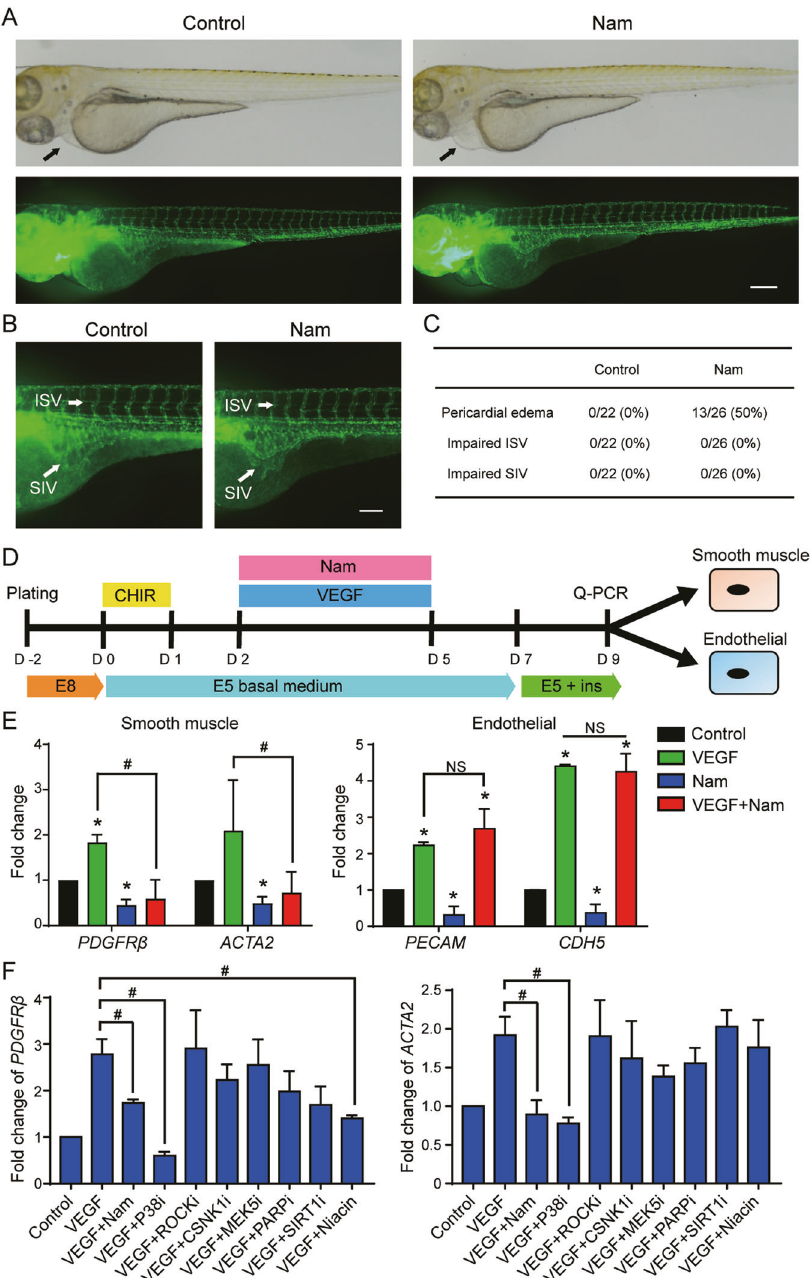
Fig. 7 The in fl uence of nicotinamide in zebra fi sh cardiovascular system development. A Effect of nicotinamide on the development of The Tg(Fli1:EGFP) transgenic zebra fi sh. Nicotinamide was applied between 18 and 24 h post fertilization. The images were taken after 3 days of treatment. Top, the bright fi eld images of zebra fi shes; Bottom, the fl uorescence images. Scale bar, 200 μ m. B The enlarged images showing the intersegmental vessels (ISV) and subintestinal veins (SIV) of zebra fi shes. Scale bar, 100 μ m. C Percentage of zebra fi sh with pericardial edema, impaired ISV, or impaired SIV ( n = 22 in control group, and n = 26 in nicotinamide group). D The schematic diagram showing the protocol of endothelial and smooth muscle differentiation. VEGF 50 ng/mL was added from day 2 to day 5 in the absence or presence of 10 mM nicotinamide. E Analyses of mRNA expression levels of PECAM , CDH5 , PDGFR β , and ACTA2 by qPCR at day 9 of differentiation. Black, Control; green, VEGF 50 ng/mL; blue, Nicotinamide 10 mM; red, VEGF 50 ng/mL and nicotinamide 10 mM. Data shown are normalized to control and represent three independent experiments (* p < 0.05 compared with control, # p < 0.05 compared with VEGF). F The indicated inhibitors were added to analyze the mechanism of nicotinamide in VEGF-induced differentiation. The mRNA levels of PDGFR β and ACTA2 were measured by q-PCR at day 9 of differentiation. The following treatments were added from day 2 to day 5 together with VEGF (50 ng/mL): Nicotinamide (Nam,10 mM), P38 inhibitor SB202190 (P38i, 10 μ M), ROCK inhibitor Y-27632 (ROCKi, 10 μ M), CSNK1 inhibitor D4476 (CSNK1i, 10 μ M), MEK5 inhibitor BIX02189 (MEK5i, 5 μ M), PARP inhibitor AZD2281 (PARPi, 100 nM), SIRT1 inhibitor EX527 (SIRT1i, 10 μ M), or Niacin (10 mM). Data shown are normalized to control and represent mean ± SD of three independent experiments (# p < 0.05 compared with VEGF).